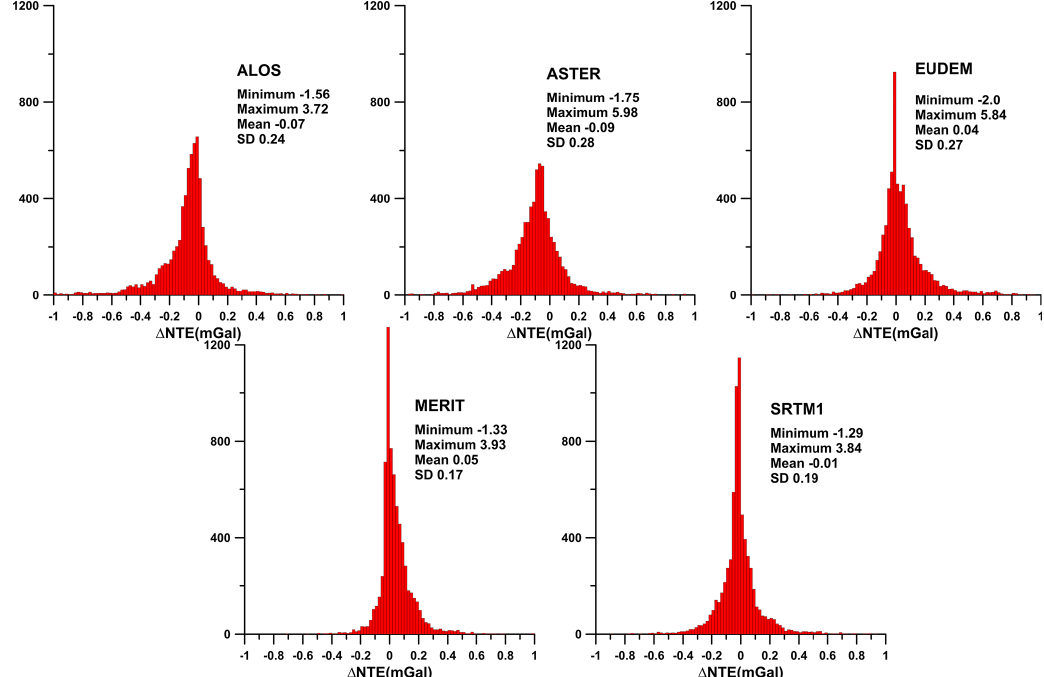
Figure D2. Near-terrain effect (or mass correction, density 2670kgm − 3 ) differences calculated using various global models compared to the local Slovak terrain model DMR-3. The test was made on approx. 8000 points covering the whole territory of